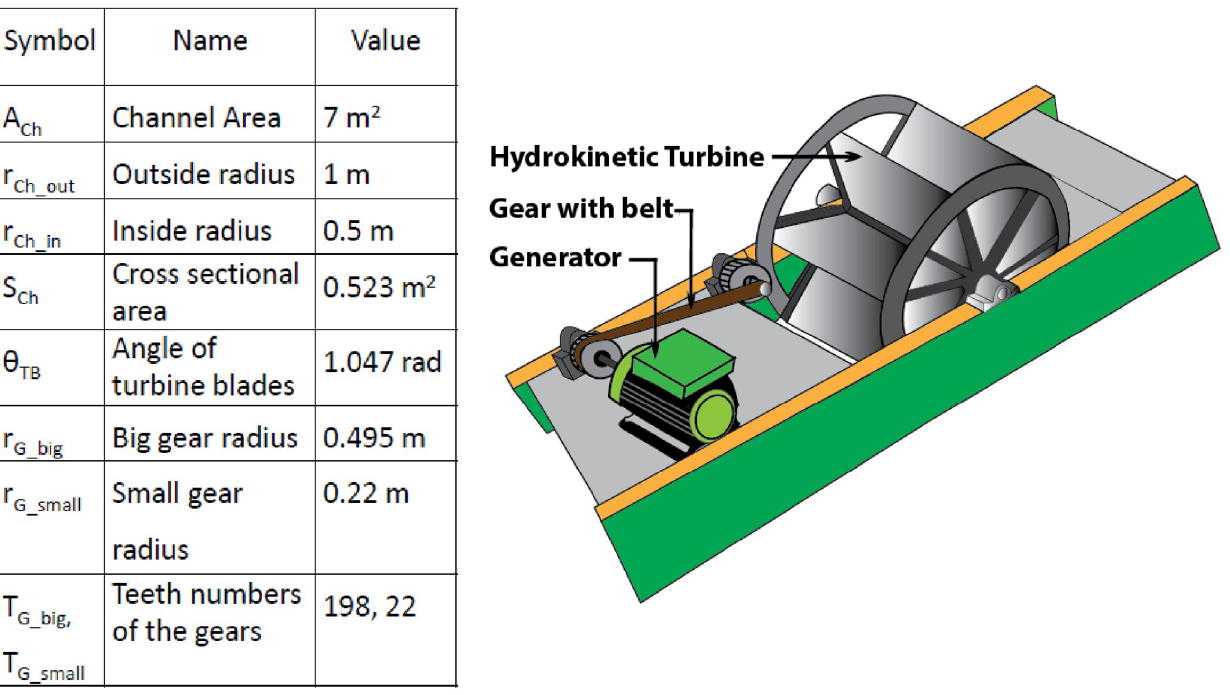
Fig 8. Proposed extension unit in the KH plant with